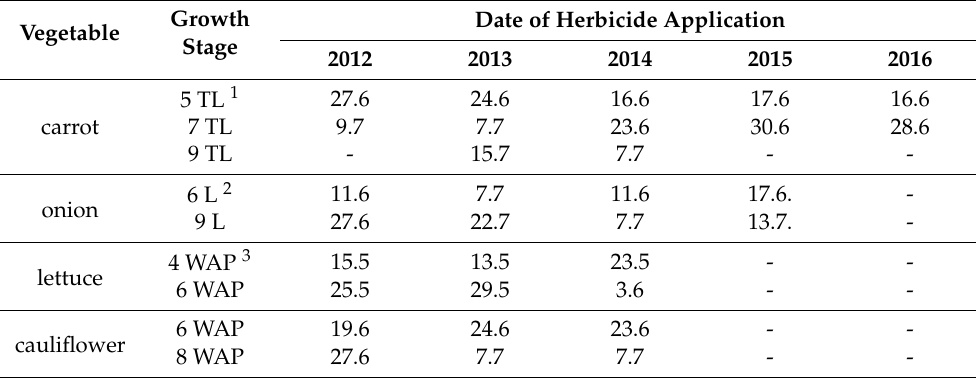
Table 3. Term of herbicide application in experimental